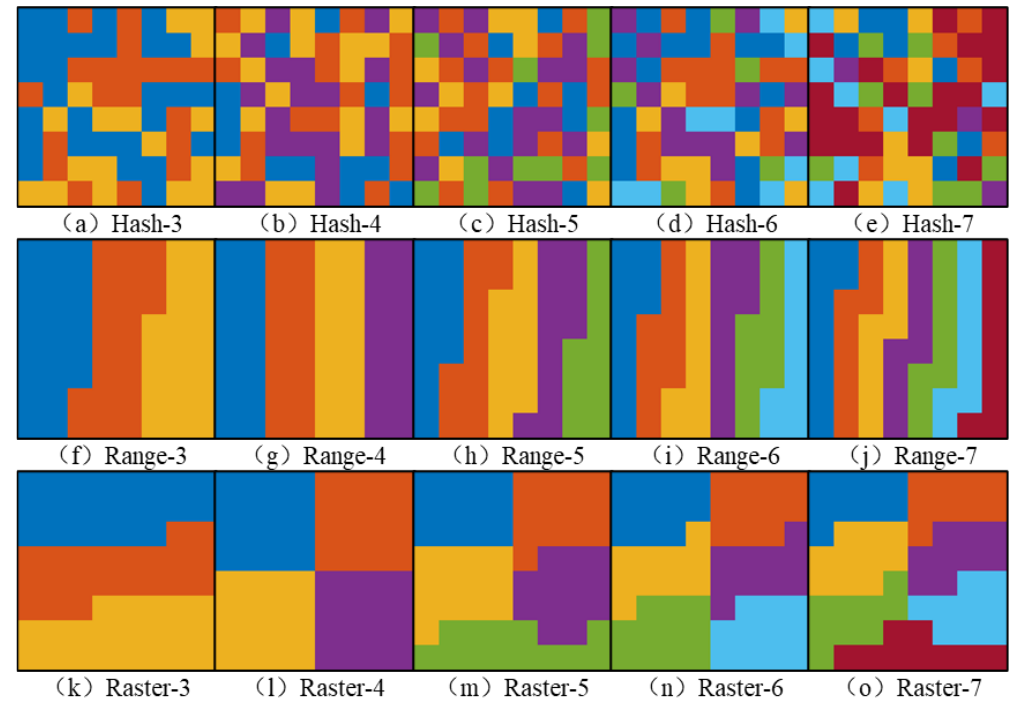
Figure 11. The partition results for the hash, range and raster partition methods over the 8 × 8- image layout.